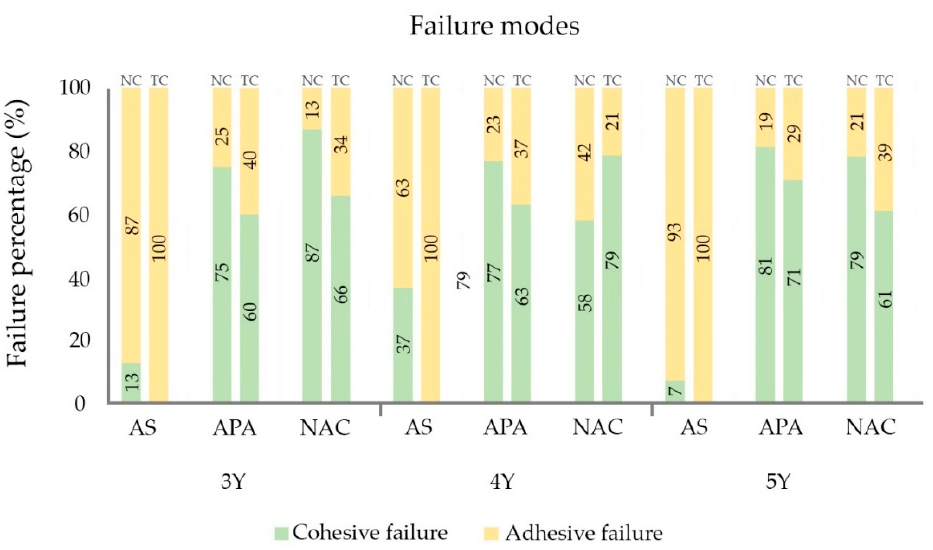
Figure 3. Mean percentages of assigned failure modes after shear bond testing of non-cycled (NC) and cycled (TC) groups.